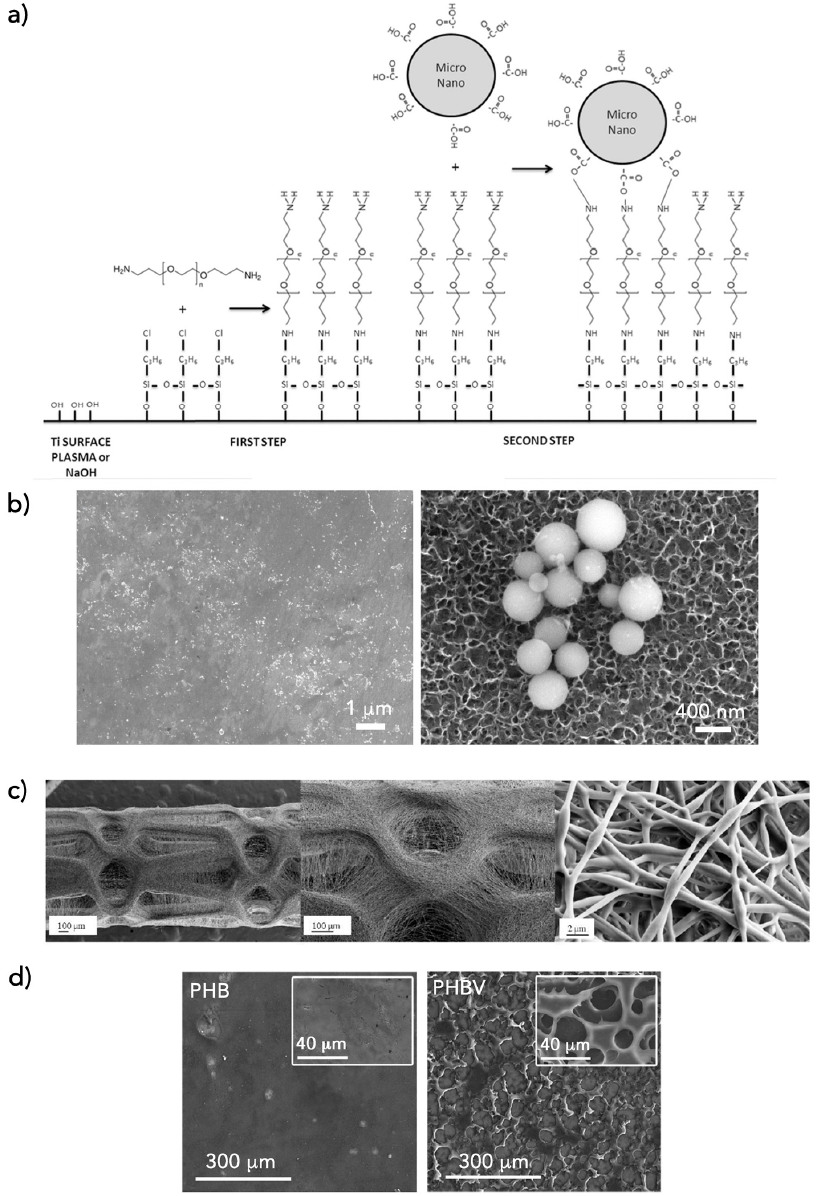
Figure 3. PHAs as drug delivery systems. ( a ) Scheme of the chemical reaction for adhesion of PHB micro- and nano-spheres on Ti surfaces: activation of the Ti surfaces (by plasma or NaOH treatment), silanization with the alkoxysilane 3-chloropropyltriethoxysilane (CPTES), covalent bounding with difunctionalized poly(ethylene glycol) (PEG), and covalent bonding with doxycycline-loaded PHB-spheres. ( b ) Field emission scanning electron microscopy micrographs of Ti surfaces with doxycycline-loaded spheres of PHB [66]. ( c ) SEM images of direct coatings of paclitaxel loaded P(3HB-co-95 mol% 4HB) nanofibers onto a metal stent (40 × , 100 × , and 5000 × ) [67]. ( d ) FESEM images at different magnifications of PHB and PHBV matrixes that totally coated Ti surfaces [69].